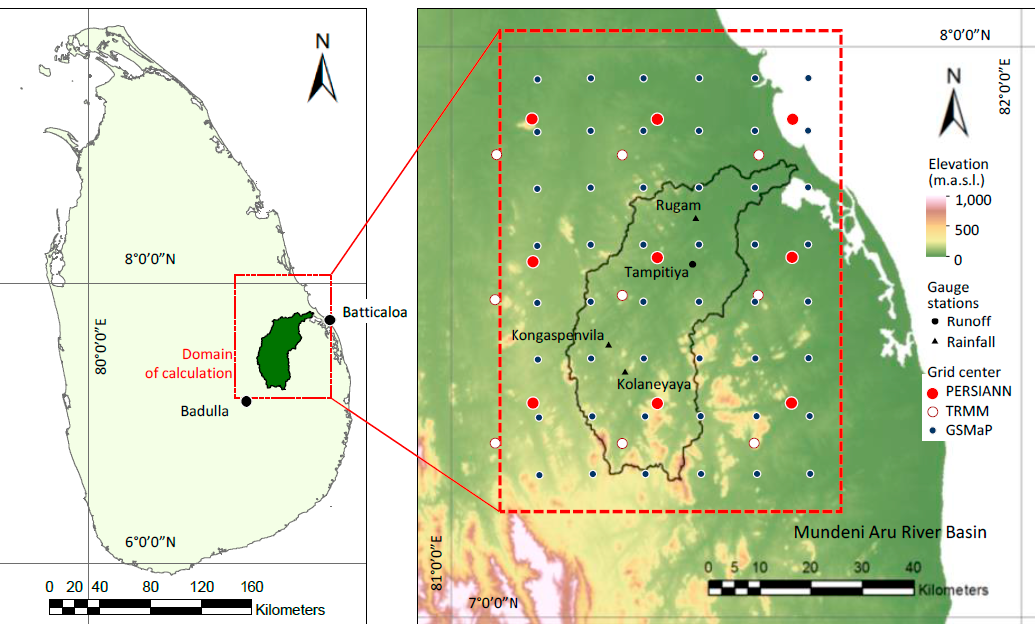
Figure 1. Domain of the calculation of the study area showing gridded points of the Satellite Rainfall Estimates (SREs) and gauge stations for runoff and rainfall.